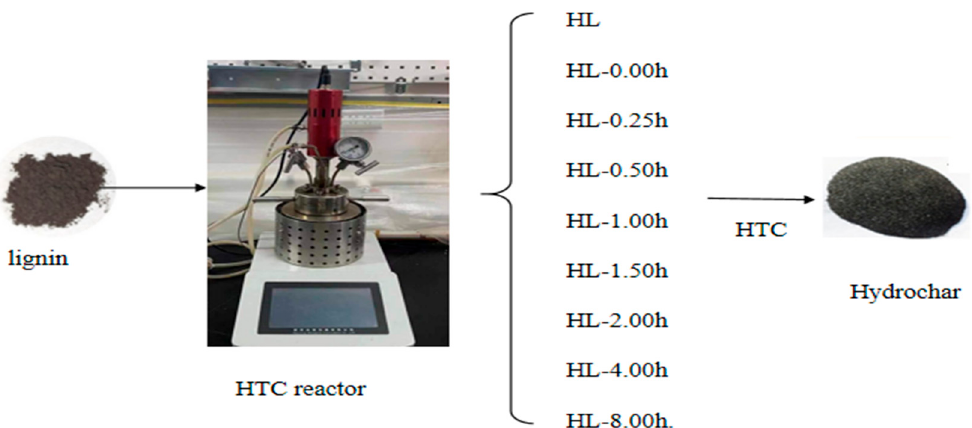
Figure 1. Schematic diagram showing the preparation of hydrochar.